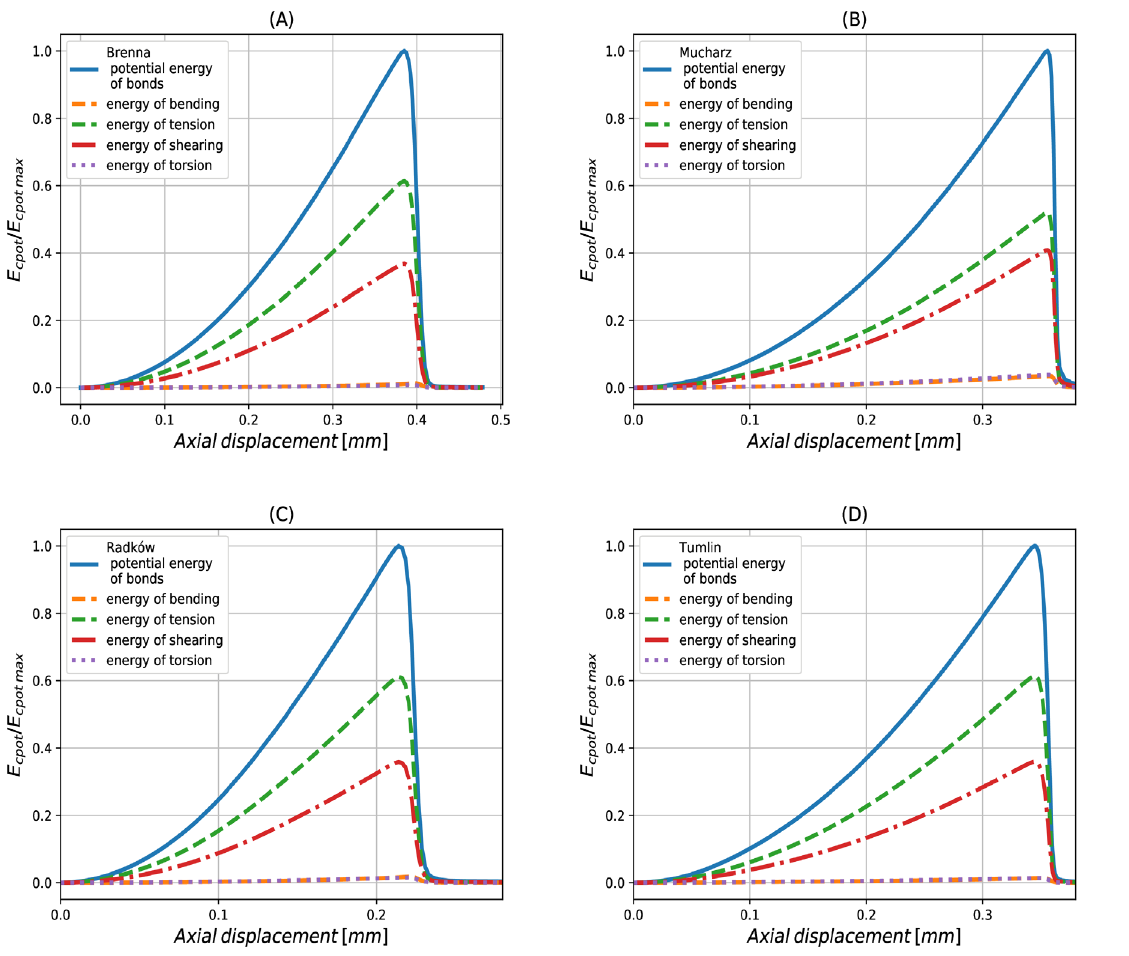
/ E – potential energy of bonds divided by maximum cpot cpot max